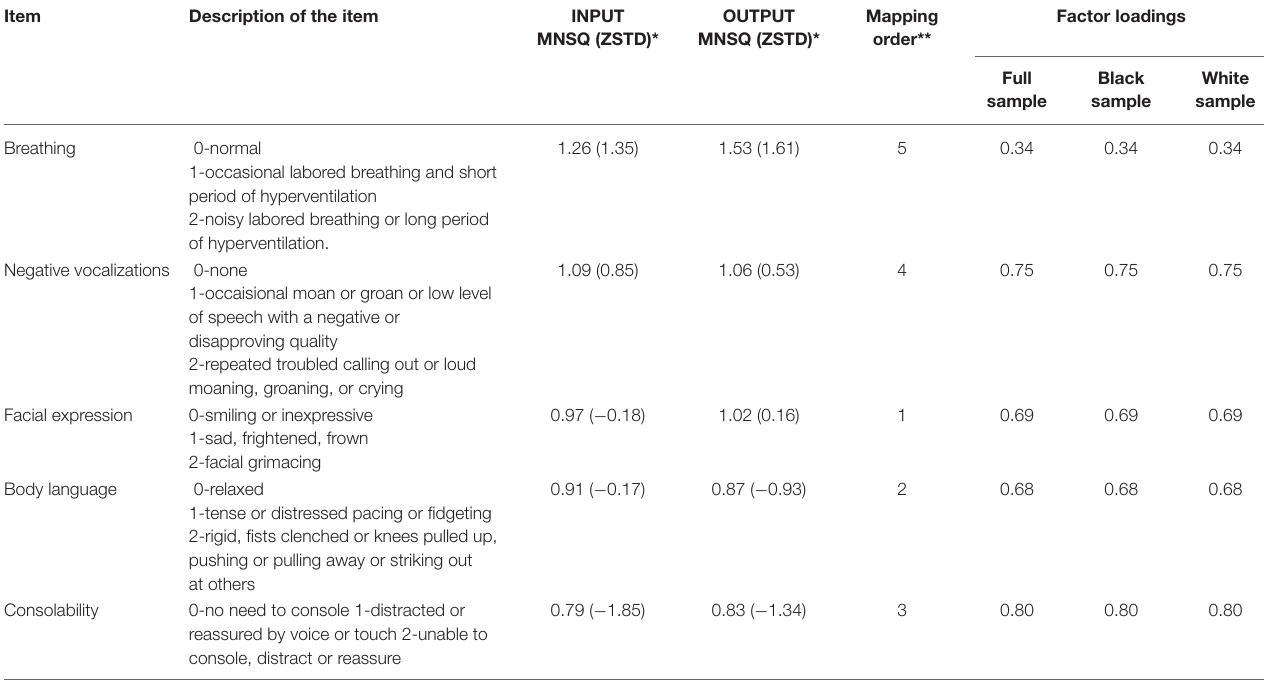
TABLE 2 | INFIT and OUTFIT statistics for the PAINAD scale, mapping order, and factor loadings for the full measurement model. Item